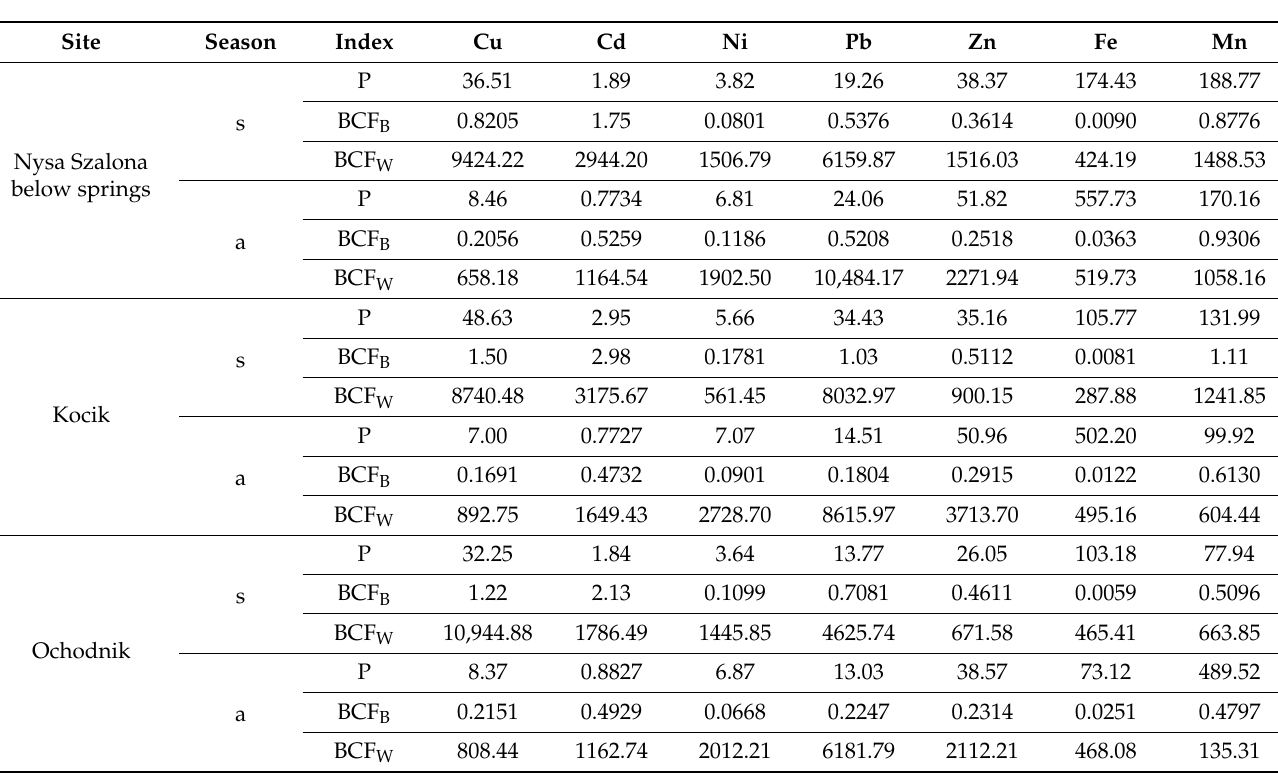
Table 9. Metals and metal bioaccumulation factors relative to water (BCF W ) and bottom sediment (BCF B ) in reed canary grass in successive tributaries of the Nysa Szalona River in spring and autumn (mean